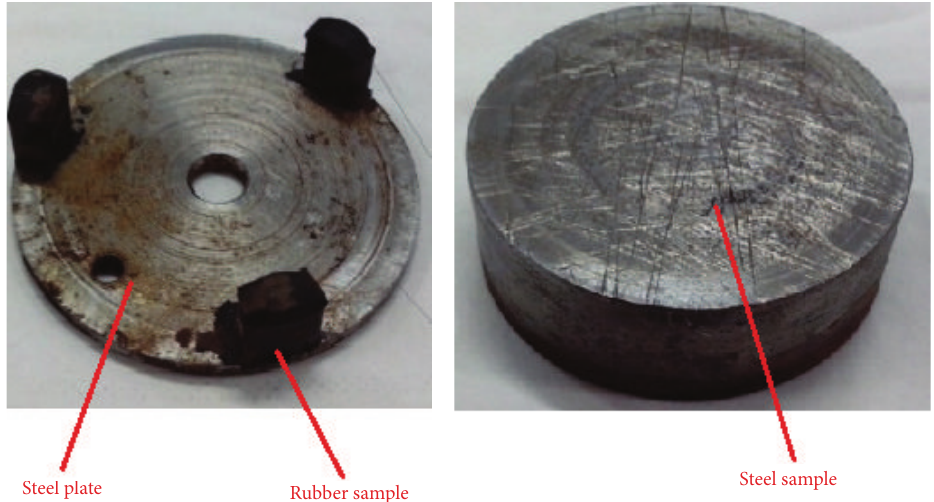
Figure 3: Samples of rubber and